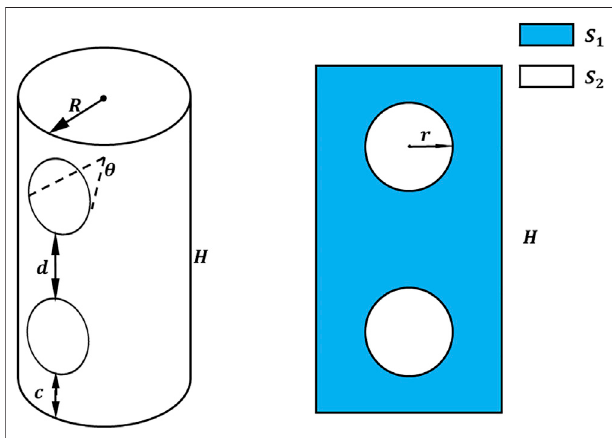
FIGURE 1 | Dimensions of an open-hole AL tube.